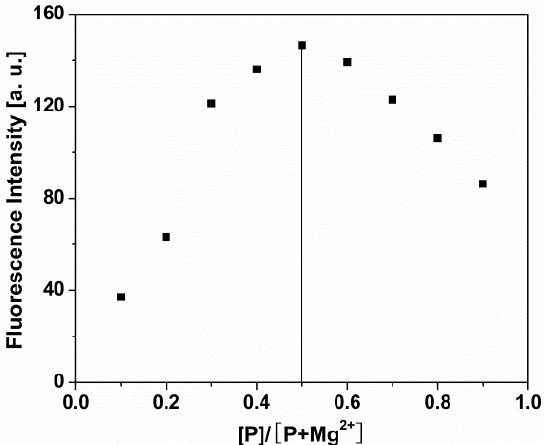
Figure 4. Job’s plot of P and Mg 2+ according to the method of continuous variation. Total concen- tration of ([ P ] + [Mg 2+ ]) was 10 μ M.